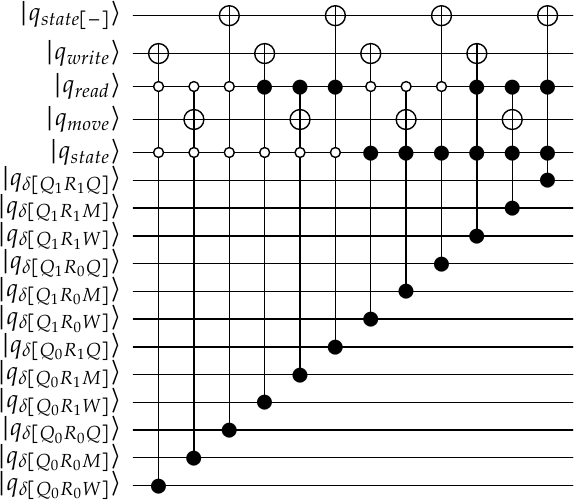
Figure A3. Transition function quantum circuit for QPULBA